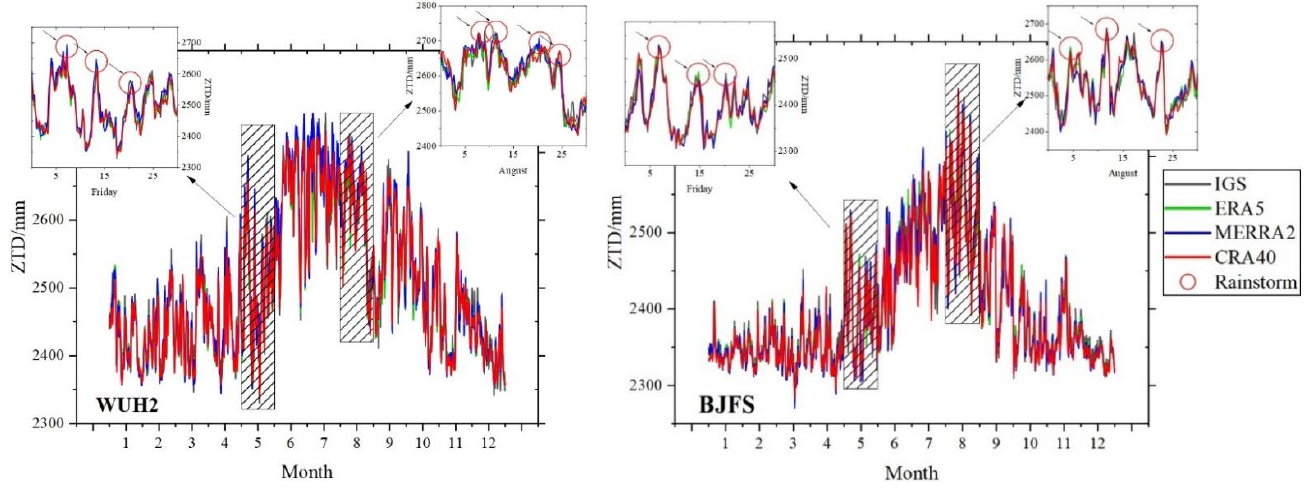
Figure 6. WUH2 and BJFS ZTD time series in 2020 (1 – 12 correspond to January – December).